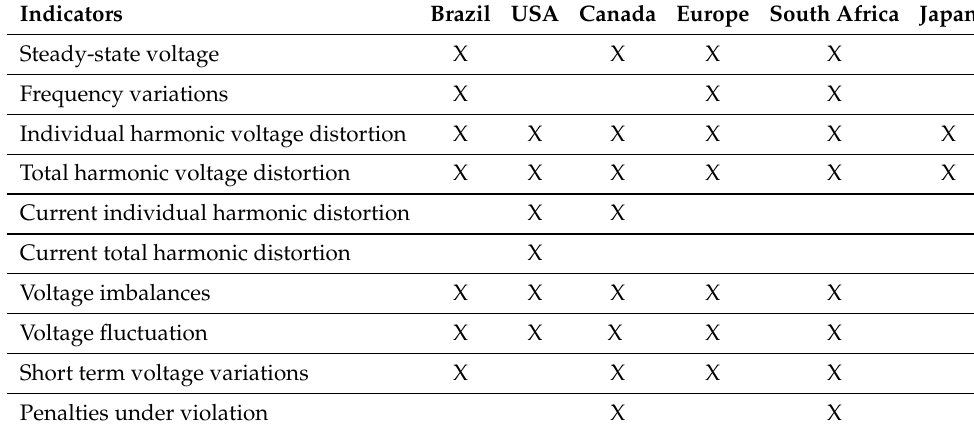
Table 1. Synthesis of the main energy quality indicators between different